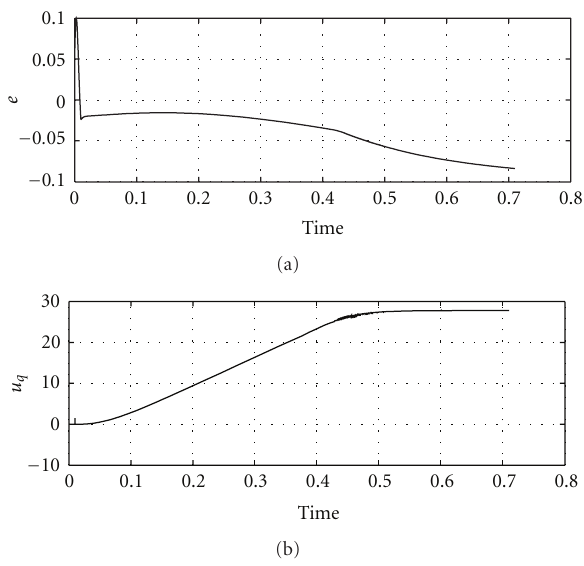
Figure 2: Performance of the tracking error and control input varying the resistance value.